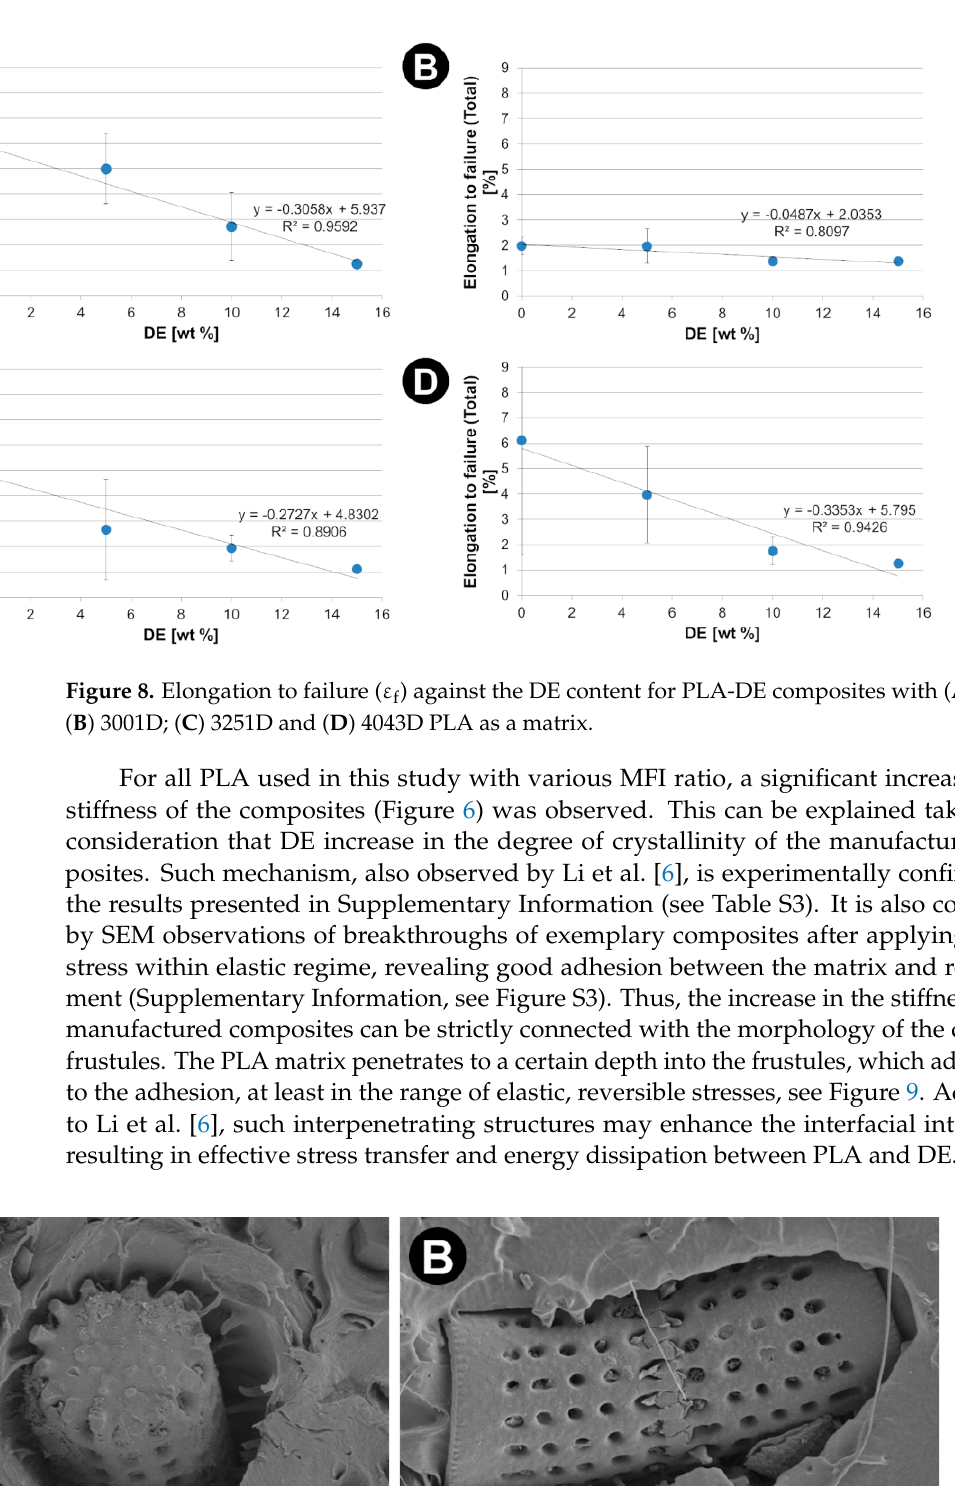
Figure 7. Ultimate tensile strength (R m ) against the DE content for PLA-DE composites with ( A ) 2003D; ( B ) 3001D; ( C ) 3251D and ( D ) 4043D PLA as a matrix.